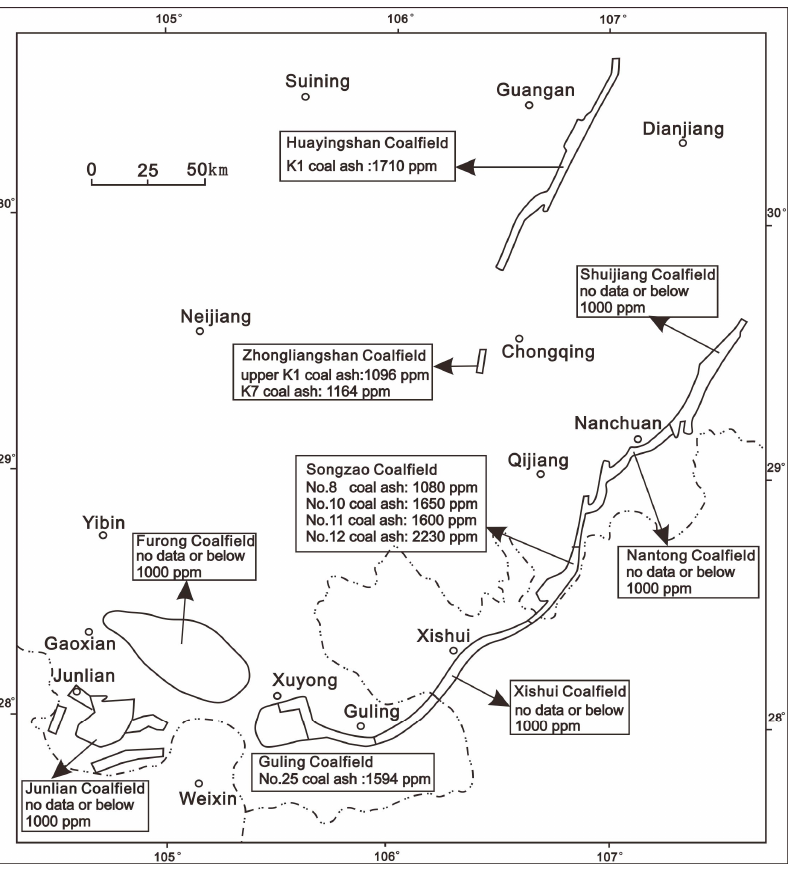
Figure 13. REY oxides (REO) concentrations in coal ash higher than 1000 ppm in Zhongliangshan and surrounding Coalfields. Tha data of Huayingshan Coalfield is from Dai et al. [8]. The data of the Songzao Coalfield is from Seredin and Dai [58]. The data of the Guxu Coalfield is from Dai et al. [82].